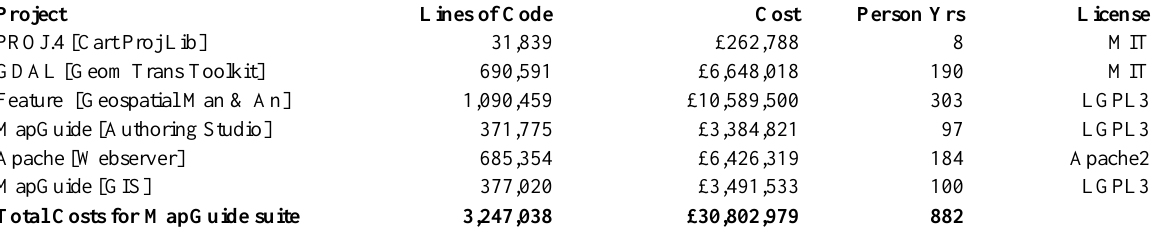
Figure 61: Bray (2010), open source software development costs; free when using OS